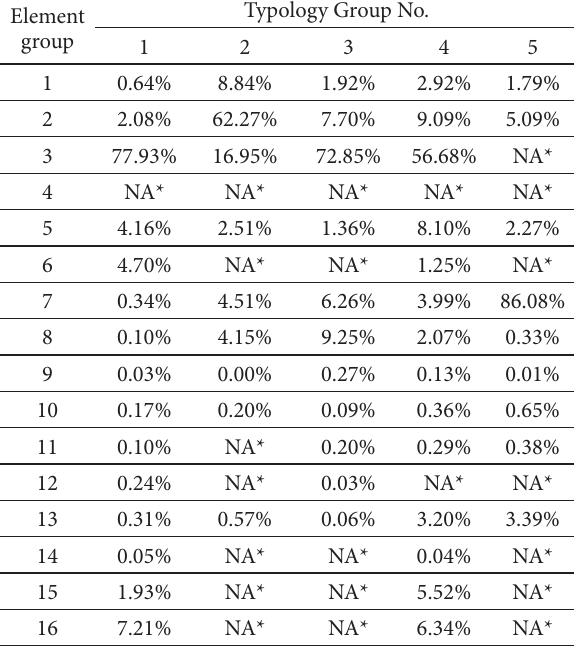
Fig. 5. Principal Component coefficients of second inspections of slab bridge typology Table 6. Weighting factors λ of different bridge